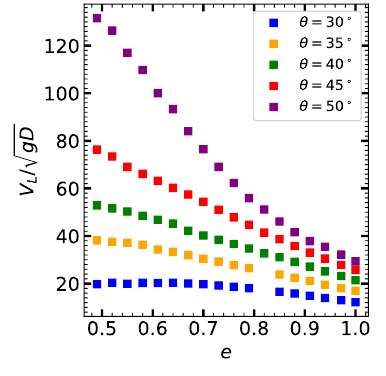
Figure 3: Mean flow velocity as a function of the restitu- tion coe  cient for various values of the inclination angle. The particle hold-up is H = 5 D .